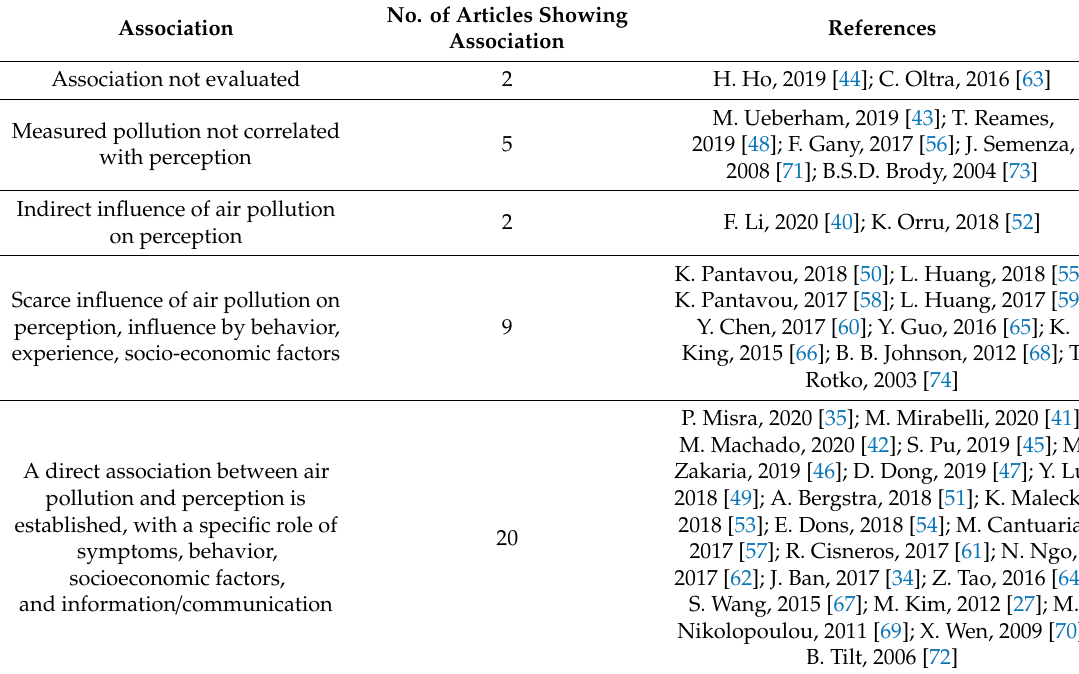
Table 3. Association between perception and measured air pollution. The number of articles for each kind of association is shown, with the references. Further details for each article are in Table